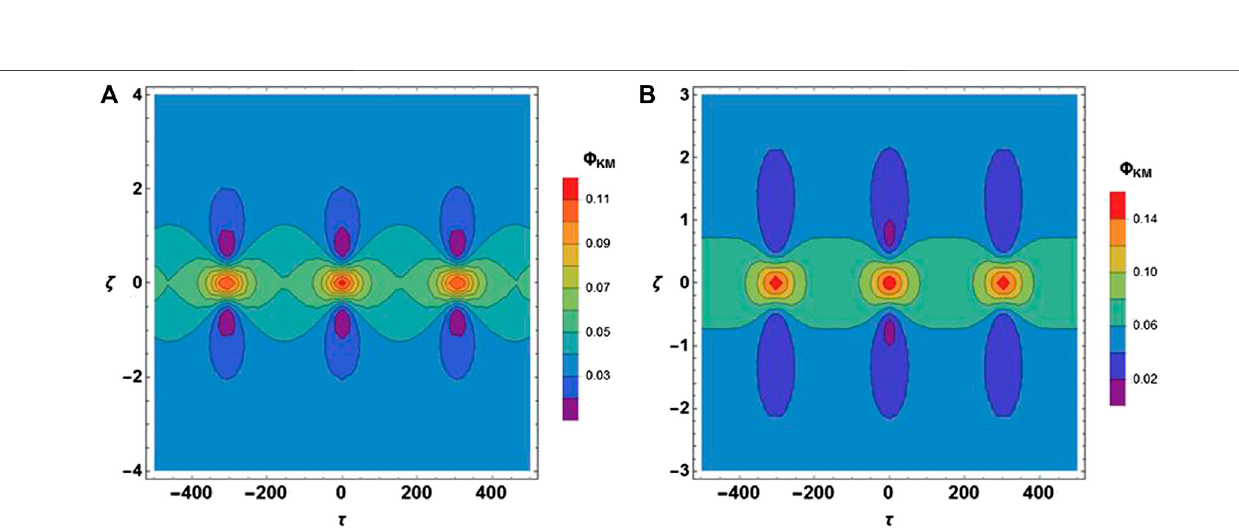
FIGURE 5 | The variation of DA Kuznetsov – Ma breather pro fi le in ζ - τ plane (A) for R (cid:1) 0 . 1 and (B) R (cid:1) 0 . 11 at fi xed values of α (cid:1) 0 . 1 and ρ (cid:1) 1 . 11.